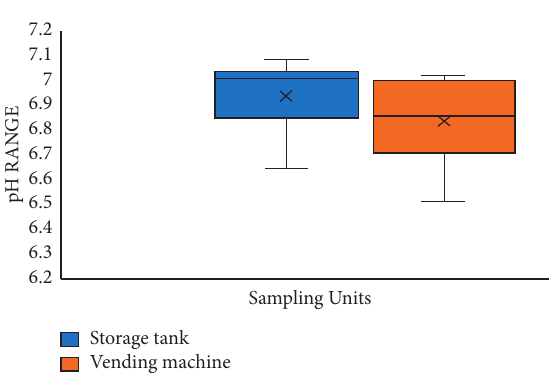
Figure 4: pH variation in milk from storage tanks and vending machines.